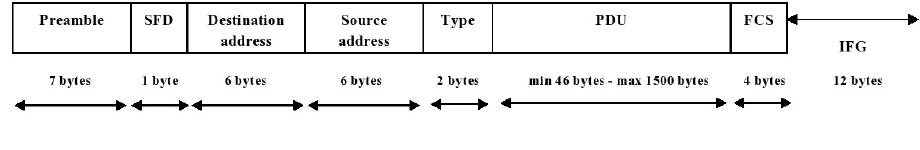
Figure 2. Ethernet v2 frame [50].